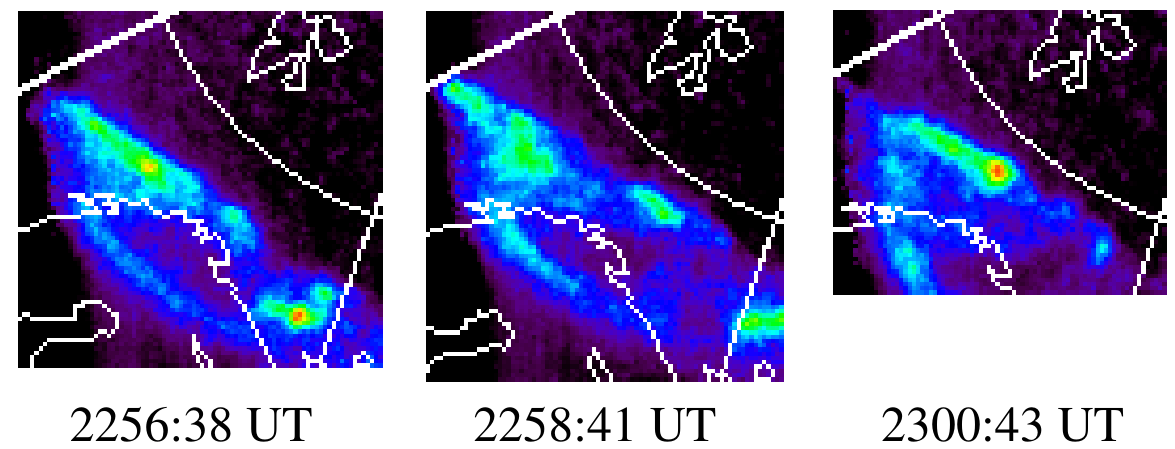
Fig. 5. Detailed view of the FUV emissions over the Scandinavian area from the WIC camera on the IMAGE satellite, for three consecutive timesteps around the flux rope event.